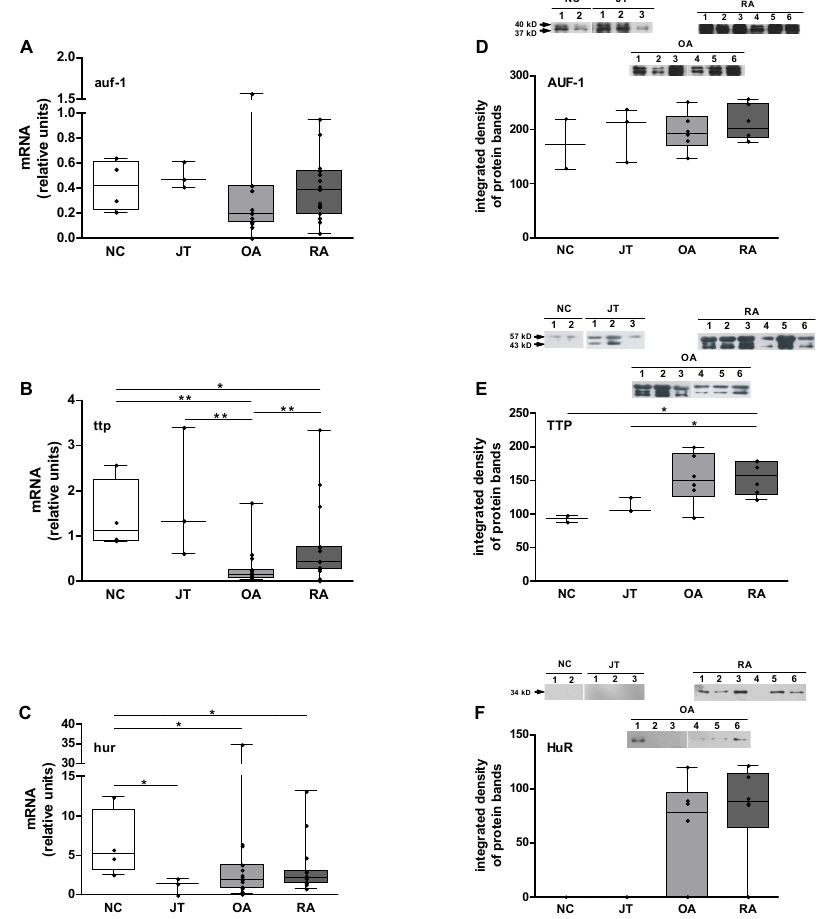
Figure 3. Quantitation of AU-rich element RNA-binding protein (AUF-1), tristetraprolin (TTP), and human antigen R (HuR) mRNA and protein expression in the SM. ( A – C ) The median relative units (as detected by pPCR) for ( A ) auf-1 , ( B ) ttp , and ( C ) hur mRNA in RA- and OA-SM (n = 15 each), JT-SM (n = 3), and postmortem NC-SM (n = 4) are given. All SM samples were positive for mRNA expression except for 1 OA sample ( auf -1), 1 RA sample ( ttp ), and 1 JT sample ( hur ). ( D – F ) The graph shows the Western blot analysis and the median integrated density of protein bands (as determined by densitometry) for ( D ) AUF-1, ( E ) TTP, and ( F ) HuR in RA-, OA- (n = 6 each), JT- (n = 3), and postmortem NC-SM (n = 2). In all groups, the samples were a subgroup of the individuals used for mRNA analysis. All SM samples were positive for AUF-1 and TTP protein expression. The number of HuR protein positive samples was 5/6 for RA-SM and 4/6 for OA-SM. In NC and JT, no HuR protein was detected. Box plots are shown with horizontal lines for the respective median, boxes represent the 25th–75th percentiles, and whiskers indicate the extremes (min to max). Statistical analyses: Mann–Whitney U-test, * p ≤ 0.05, ** p ≤ 0.01.